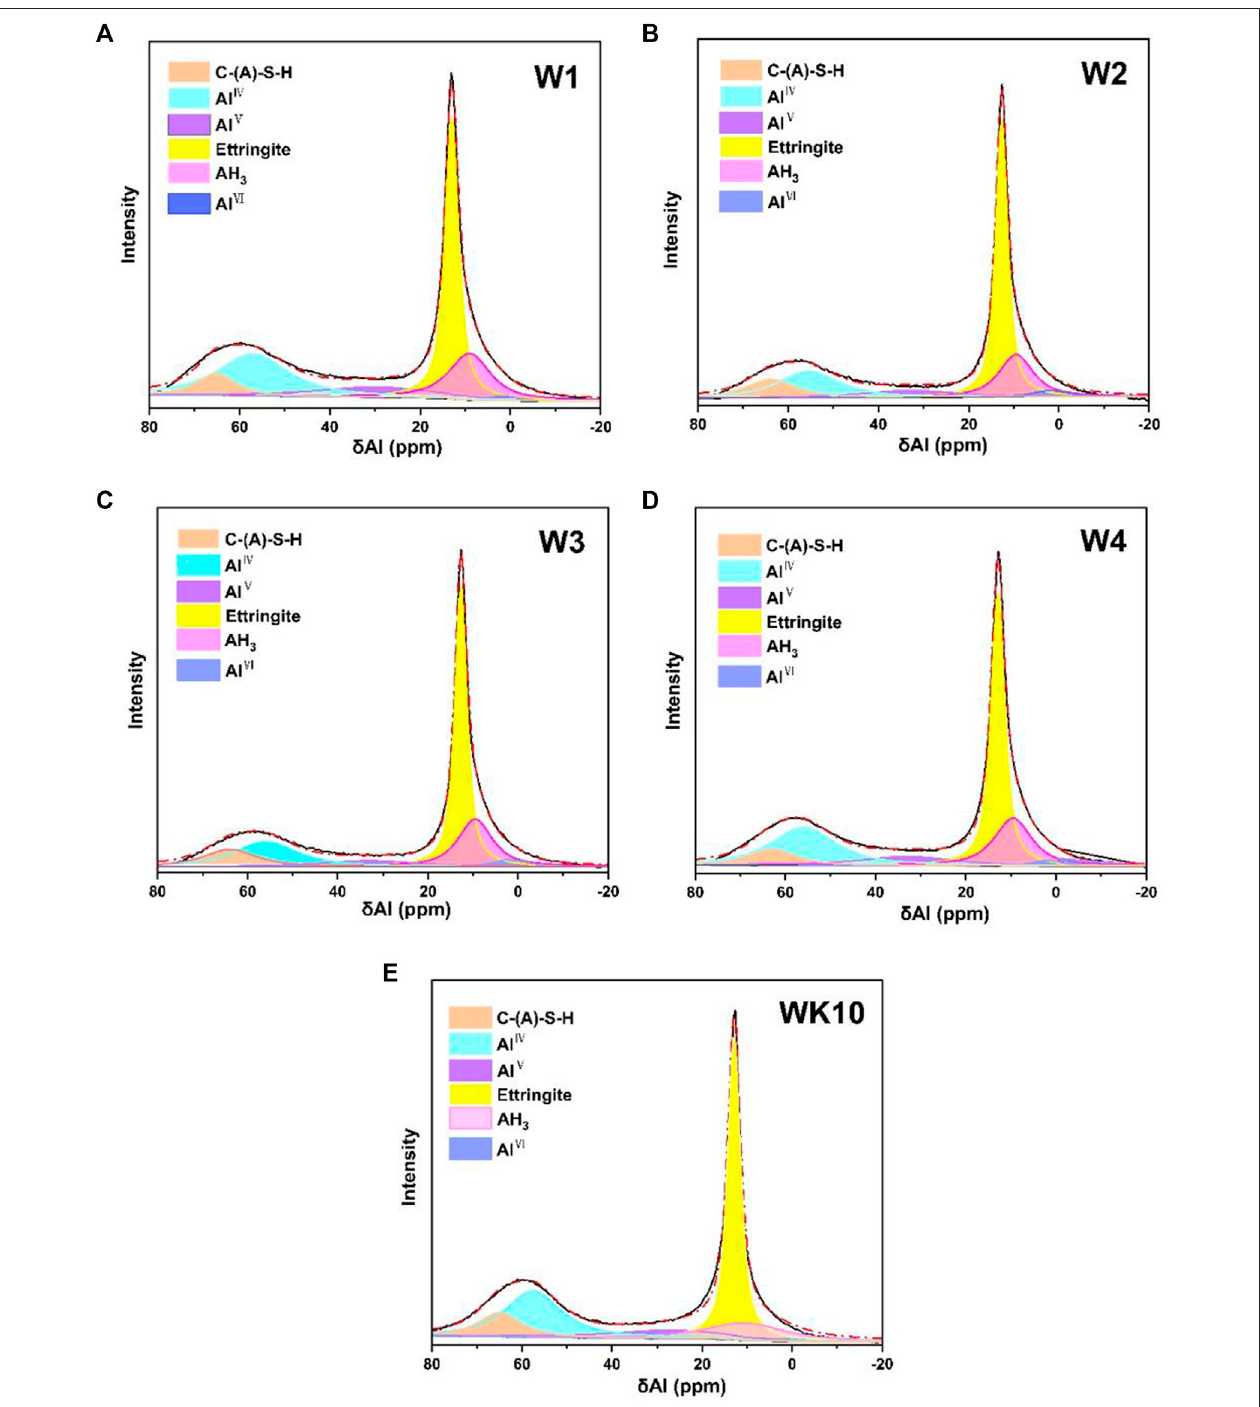
FIGURE 9 | 27 Al NMR deconvolution of P-SSC binders at 28 days: (A) W1, (B) W2, (C) W3, (D) W4, and (E) WK10.